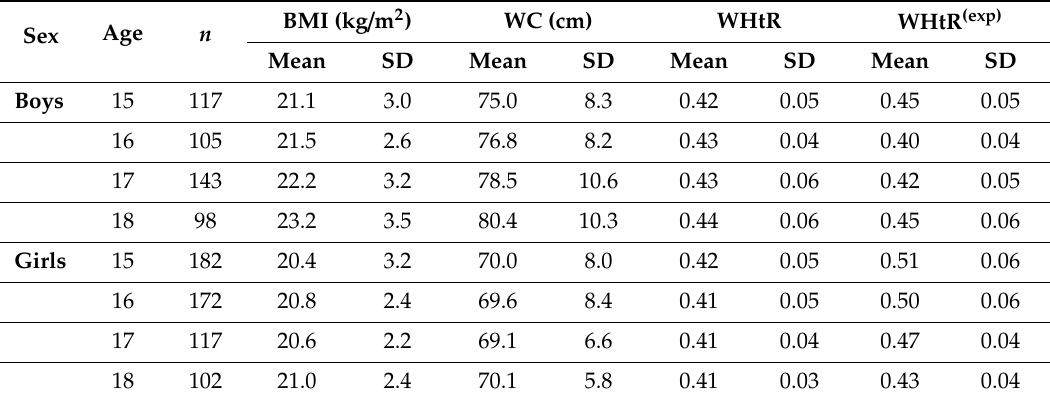
Table 1. Basic descriptive statistics of the study participants (Croatia,